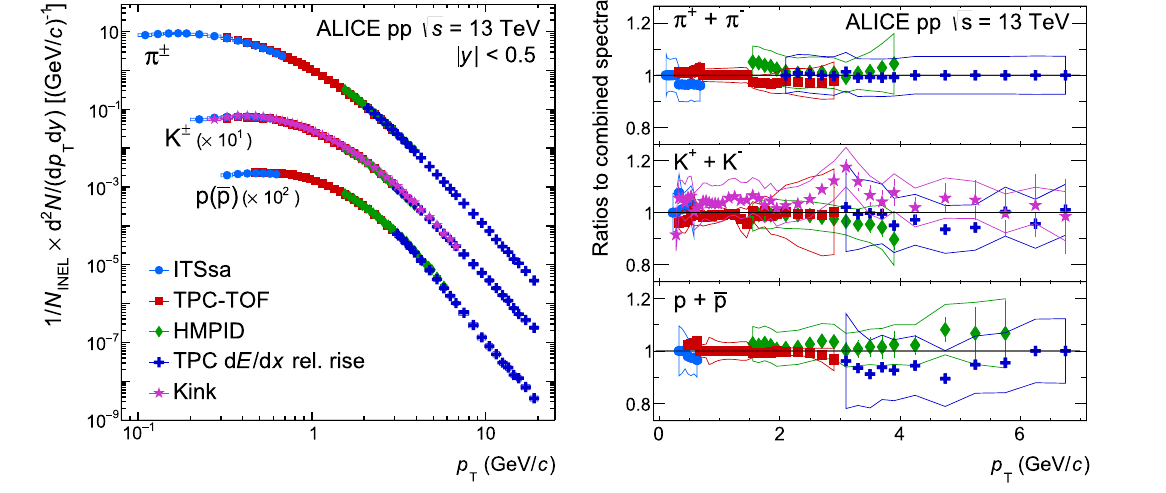
Fig. 3 Left panel: p T spectra of π ± , K ± , and p ( p ) measured at midra- bined spectra as a function of p T for π ± (top), K ± (middle), and p ( p ) √ s = 13 TeV using different pidity ( | y | < 0 . 5) in pp collisions at (bottom). Only the p T -range where the analyses overlap is shown. The PID techniques. The spectra are normalized to the number of inelastic vertical bars indicate statistical uncertainties while the bands show the collisions. Right panel: The ratios of individual spectra to the com- uncorrelated systematic